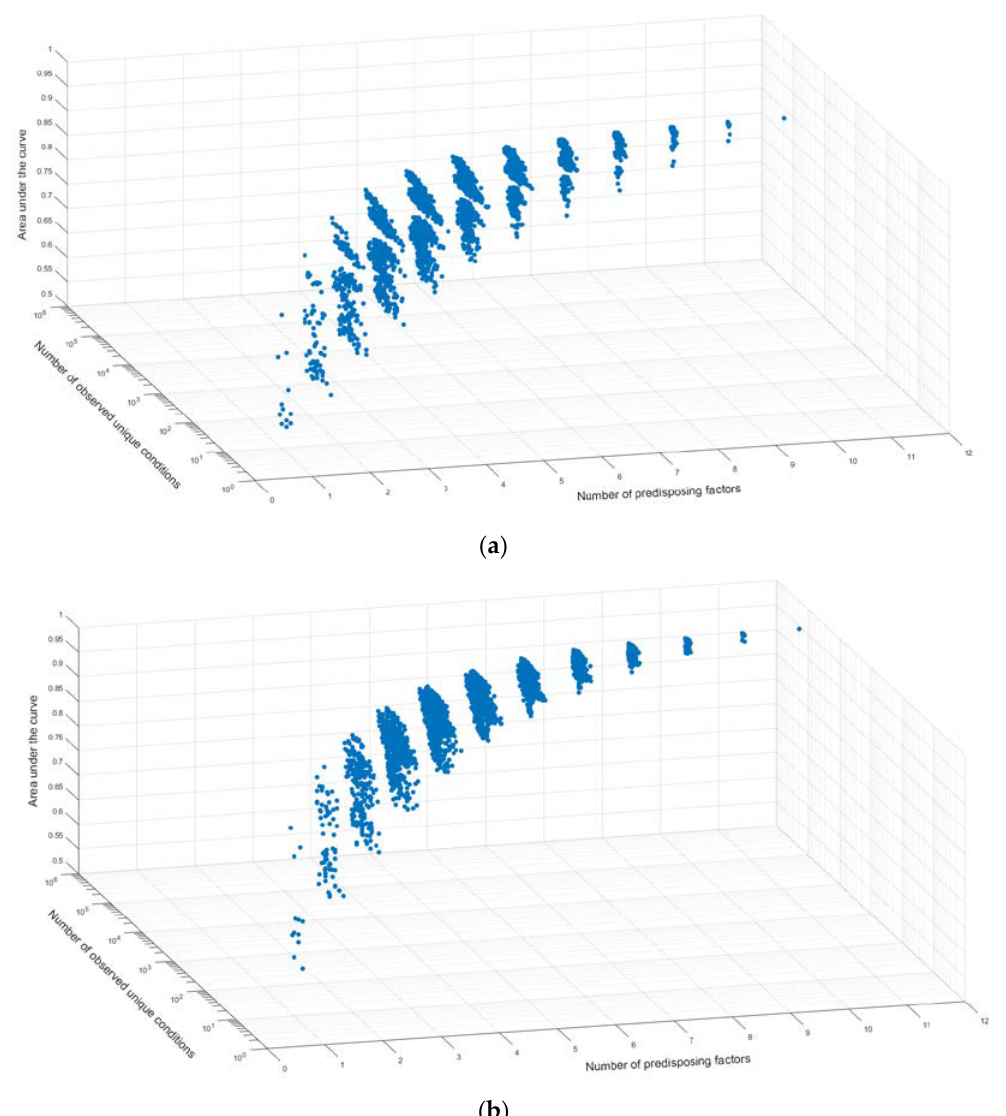
Figure 9. Variation susceptibility models’ goodness of fit relative to the number of predisposing factors used in the susceptibility models and the observed unique terrain conditions for: ( a ) falls and ( b ) slides.